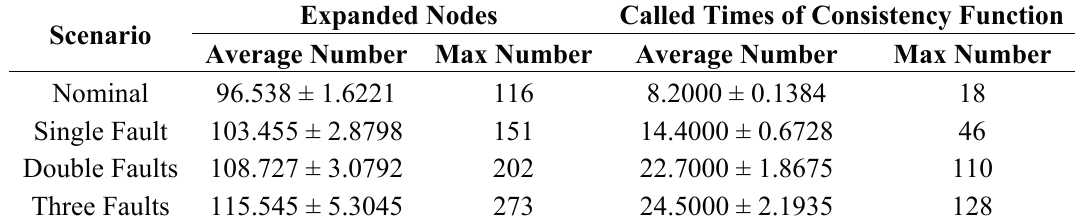
Table 5. The sizes of expanded nodes and the called times of consistency function per time step (confidence 95%).